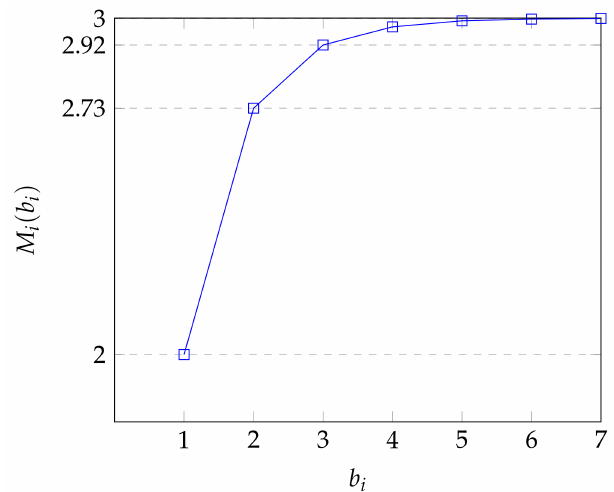
Figure 1. Limit service rate in the node S i for λ i = 1.0, µ i = 2.0.